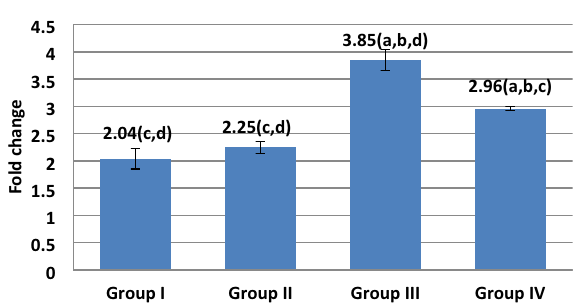
Figure 4. Effect of FUC treatment on DPP4 mRNA gene expression. values are represented as mean ± SD. Data are represented as mean ± SD. Statistical analysis was carried out using one-way ANOVA with Tukey’s post hoc test, SPSS computer program. a–d Significant difference between groups at * p < 0.05. a Significance from group I; b significance from group II; c significance from group III; d significance from group IV. Degree of freedom is (3) between groups and (24) within groups (total = 27).